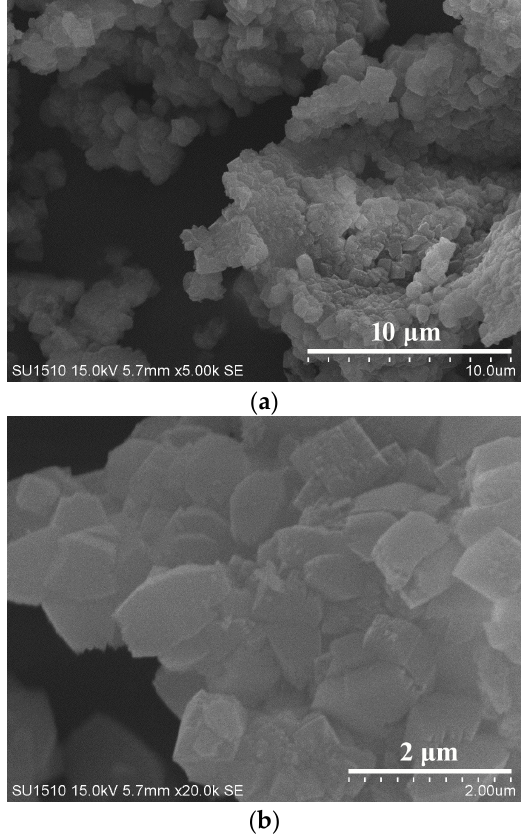
Figure 2. ( a ) Low magnification and ( b ) high magnification SEM images of as-synthesized S-Beta zeolite at 140 °C for 60 h.